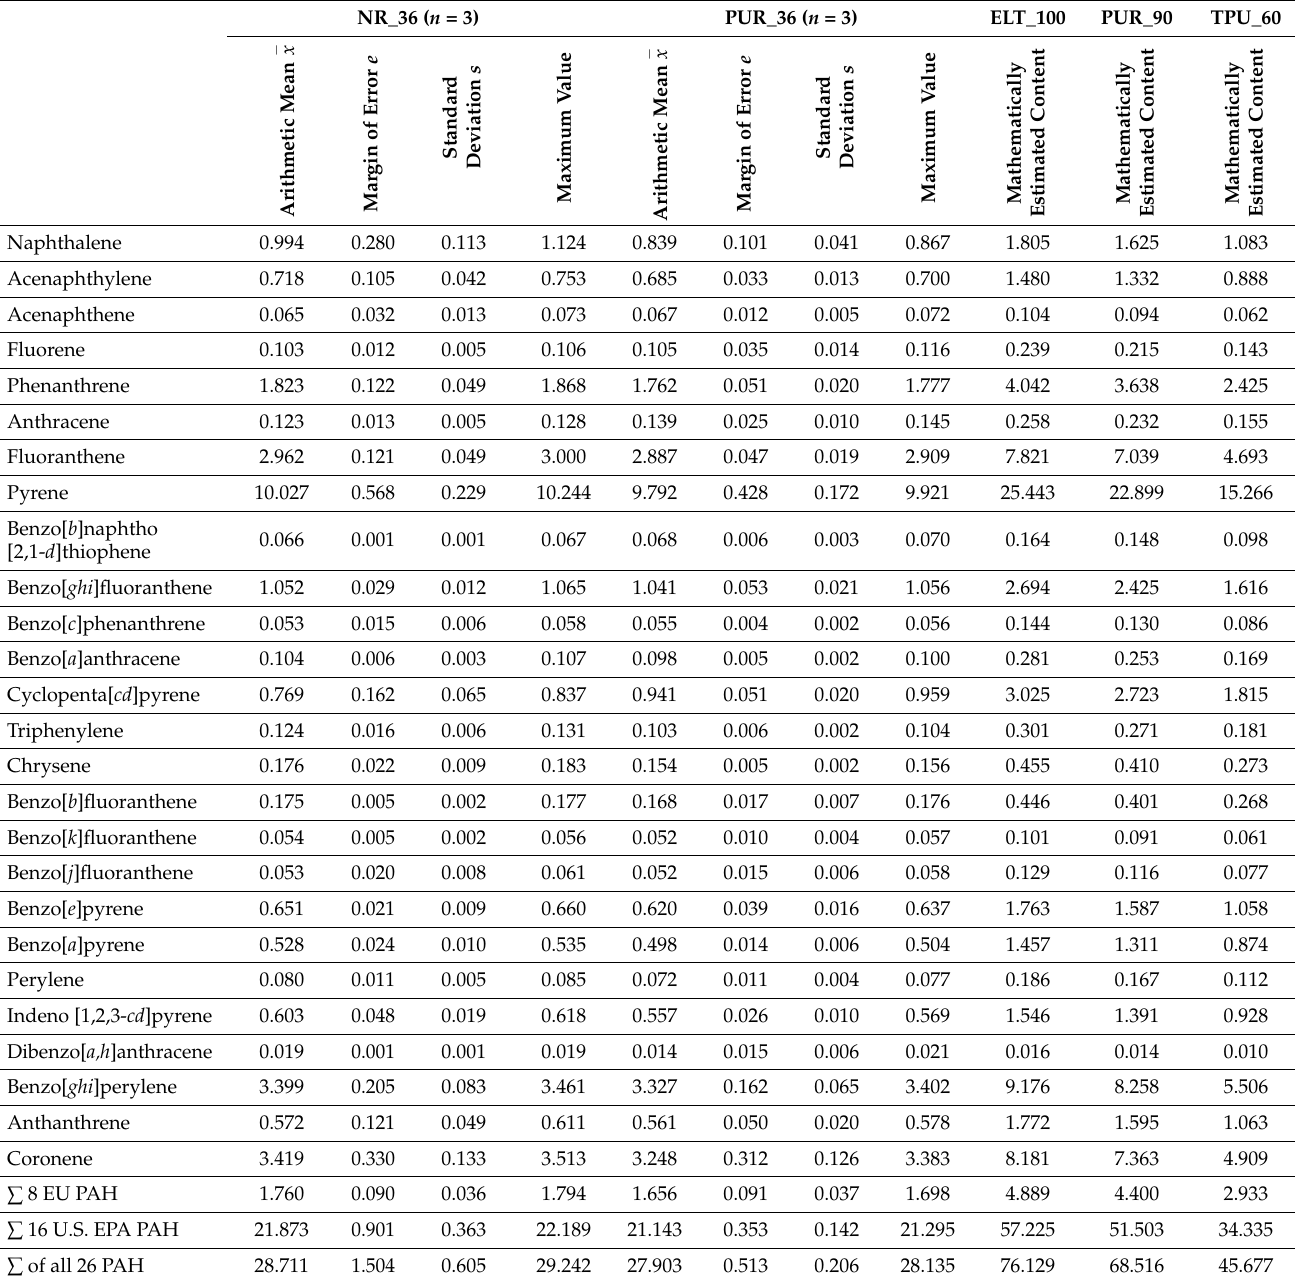
Table A1. PAH content of the materials w C in